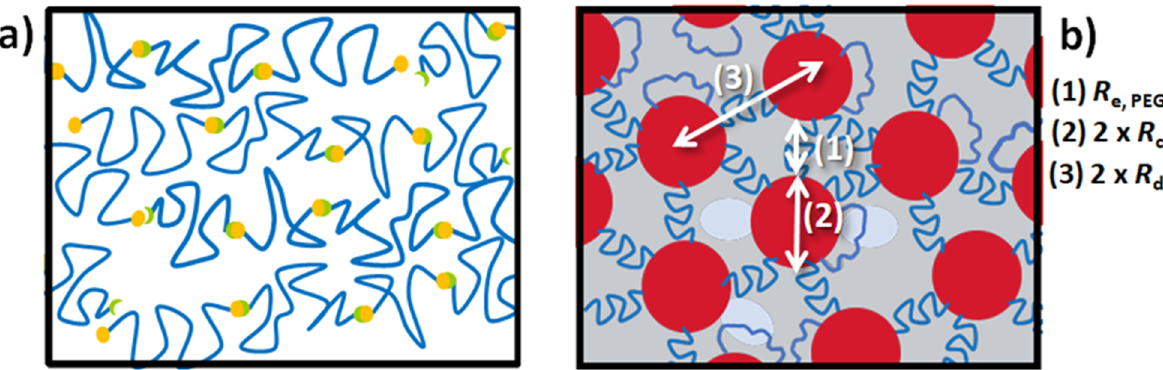
Scheme 2. Representative pictures of ( a ) PEG-thy/dat (the green and orange objects represent thy and dat, respectively) and ( b ) the PEG-upy systems structure based on the small angle scattering results (the red objects are the spherical clusters formed by the upy H- bonding end groups and the blue objects represent the stretched PEG polymer chains that give the distance between the disordered upy spheres).